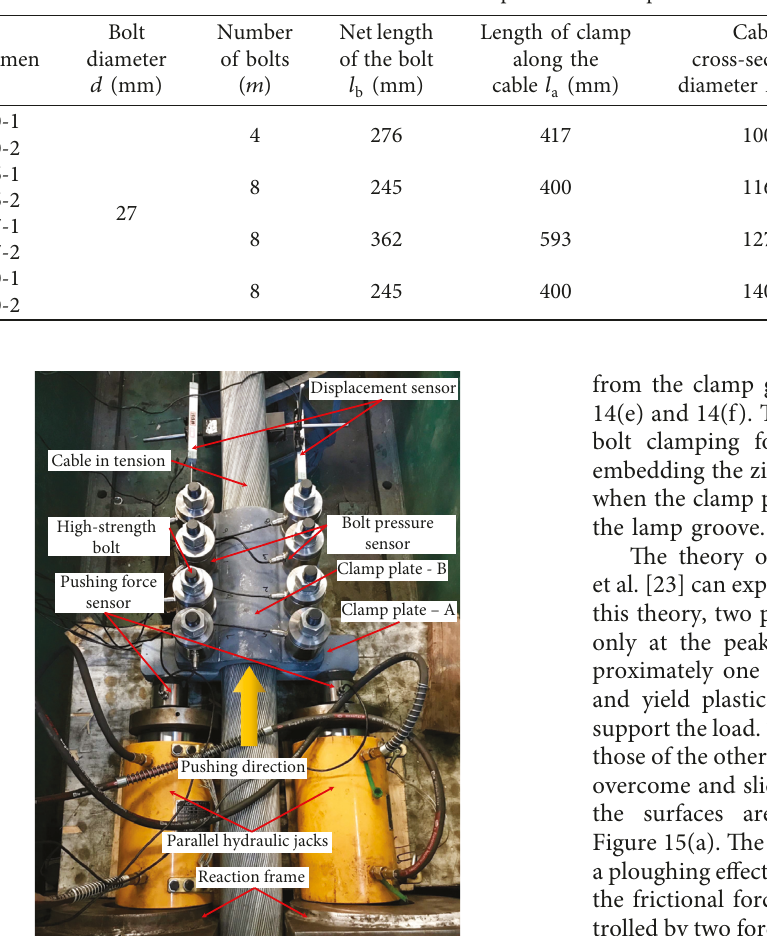
Table 3: Specification of specimens.